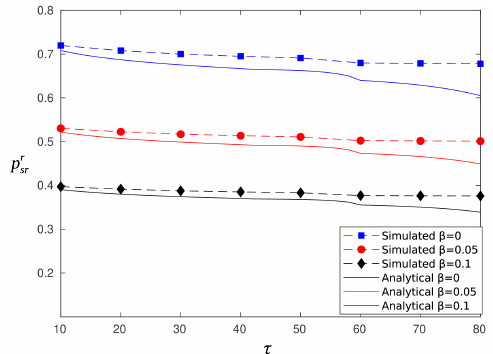
Figure 6. Probability of successful reporting, p r sr , for randomly selected sectors.